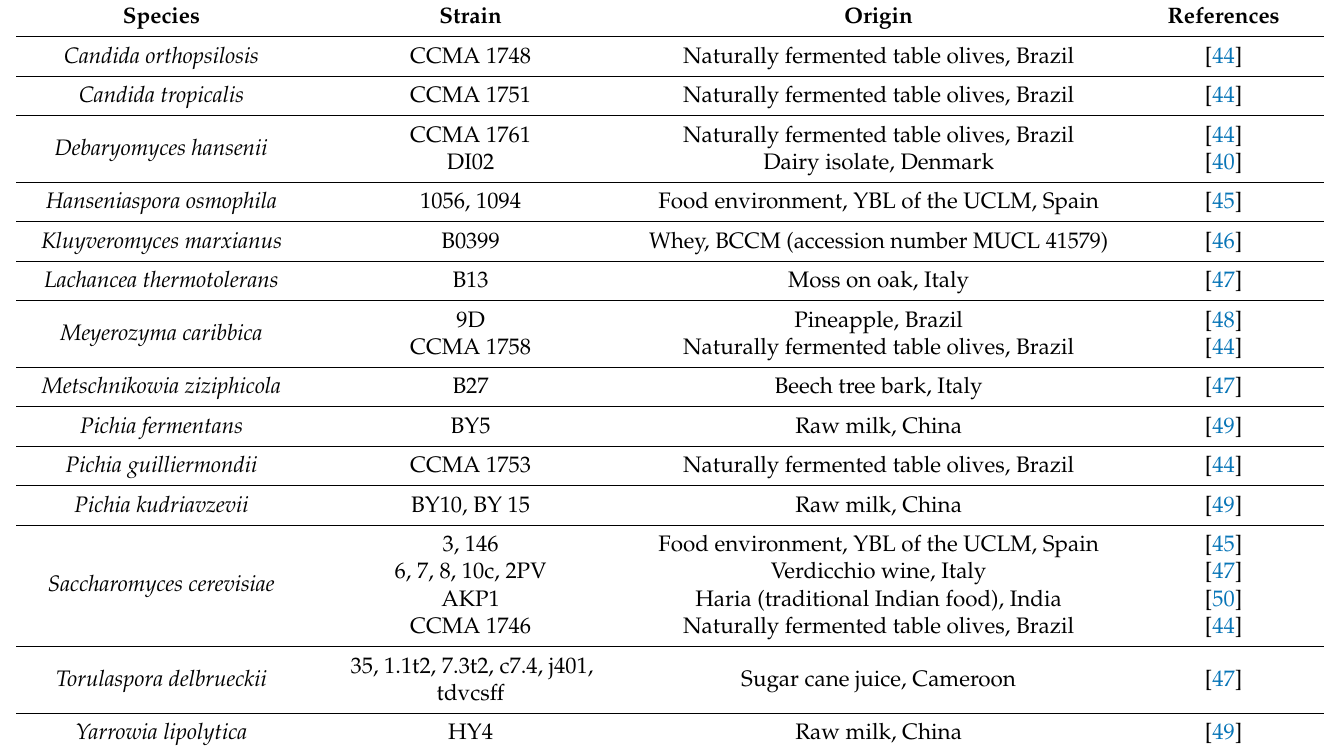
Table 3. Novel potentially probiotic strains of